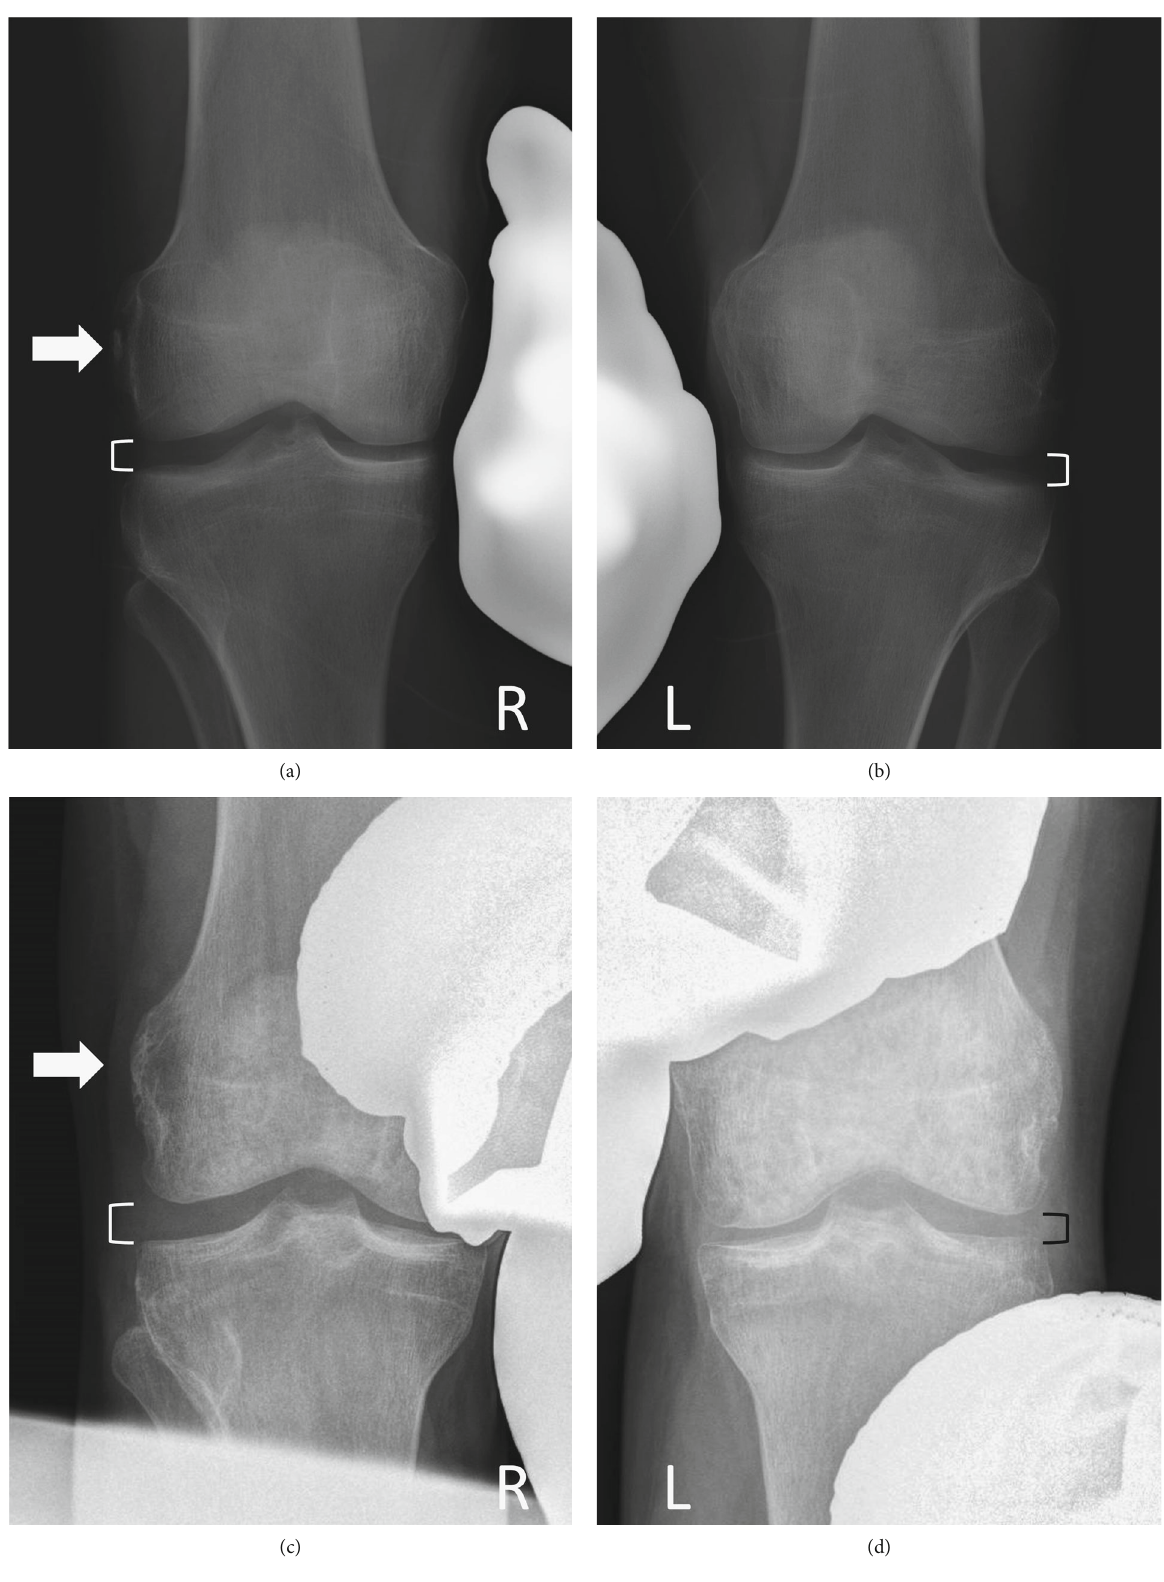
Figure 4: Comparative varus stress X-rays. (a and b) Patient case 1, at 14 months. Radiographic bone union of the fracture on the right knee (white arrow) as well as symmetrical side-to-side opening of the lateral compartment (white brackets). (c and d) Patient case 2, at 5 months. Radiographic bone union of the fracture on the right knee (white arrow) and 2mm side-to-side di ff erence between the right knee (white bracket) and the left knee (black